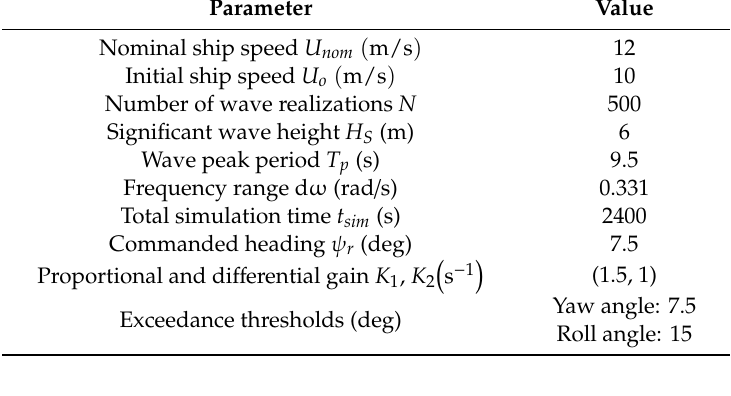
Table 1. Parameters of the base scenario.